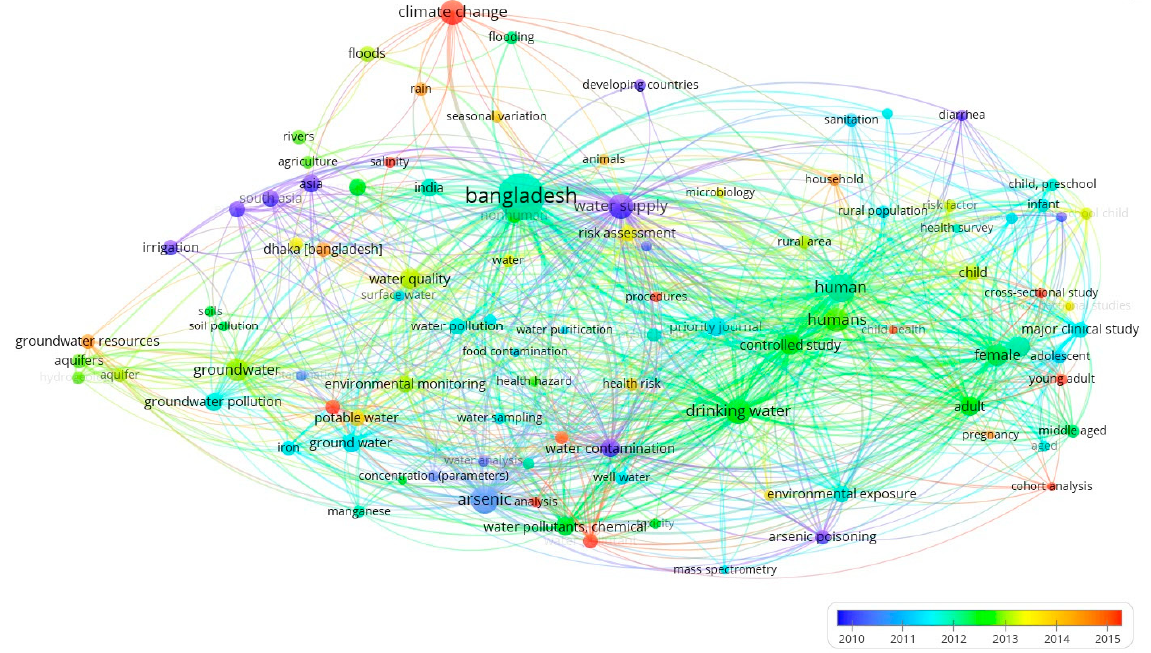
Figure 6. Occurrence network map of index keywords from Bangladesh water-research - related publications .